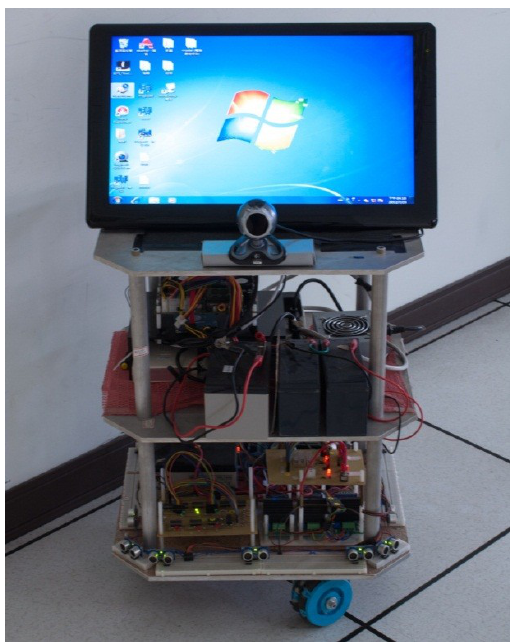
Figure 1. Omni-directional mobile robot.